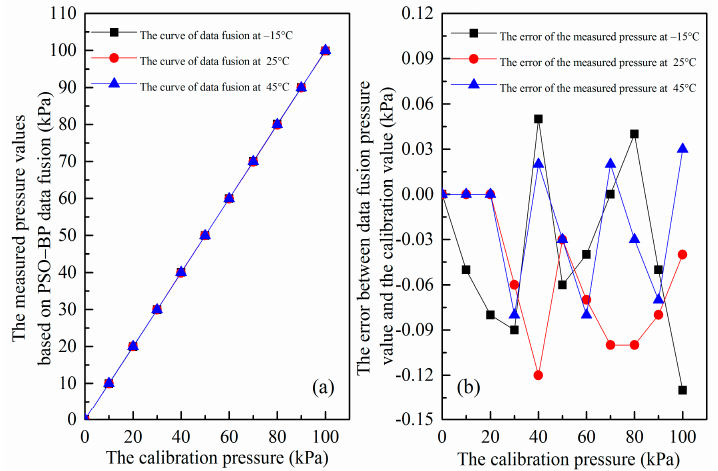
Figure 14. ( a ) The relationships between the actual measurement pressures of the digital SiNW pressure sensor designed in the paper and the calibration pressure at different temperature; and ( b ) the absolute error between the corrected pressures and the calibration pressures at different temperature.